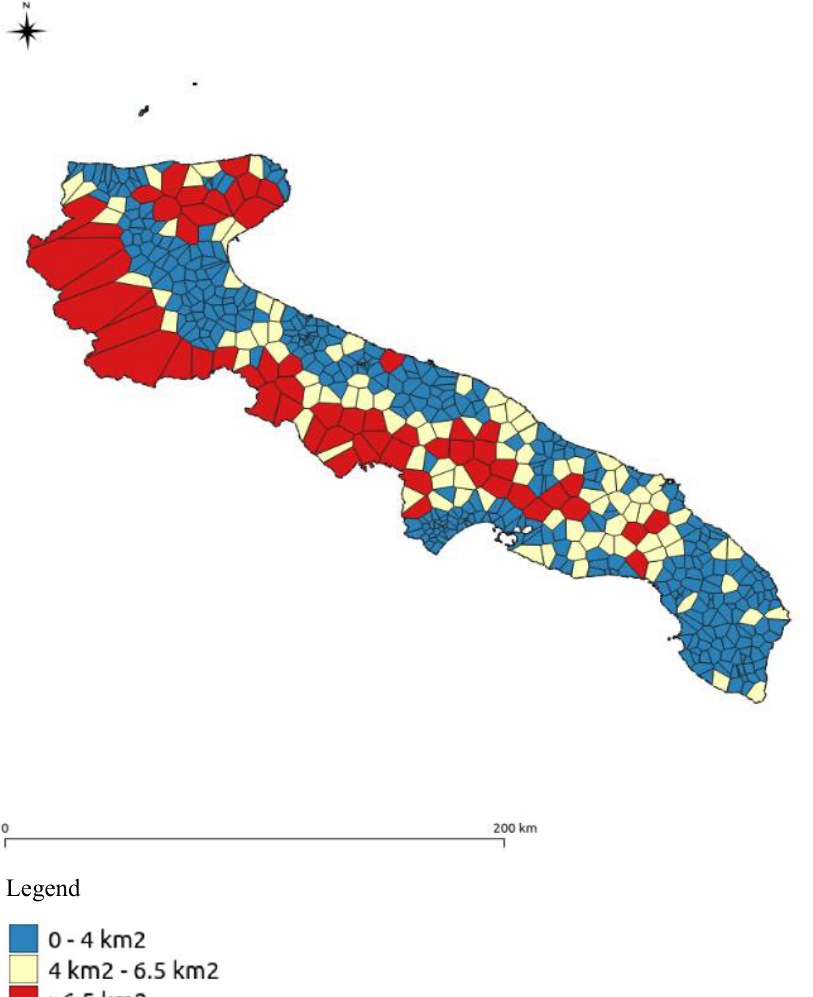
Figure 5. Subdivision of the Puglian territory into polygons of influence and classification based on their extension.